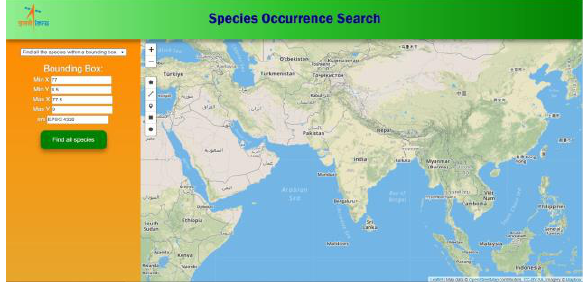
Figure 4. WPS Web Client- Species Occurrence Search by Bounding Box